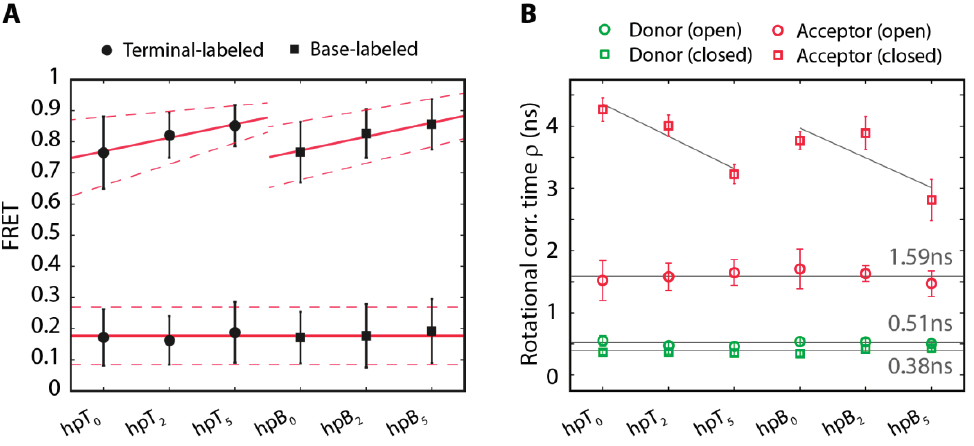
Figure 3. ( A ) FRET efficiencies of the low FRET (open) and high FRET (closed) population, with two sigma deviations, for the 5'-modified terminal- and the base-labeled DNA hairpin constructs. The data were extracted from bursts with FRET-2CDE smaller than 15; ( B ) Related steady state rotational correlation times, obtained from steady state anisotropy fits by the Perrin equation (lines are a guide to the